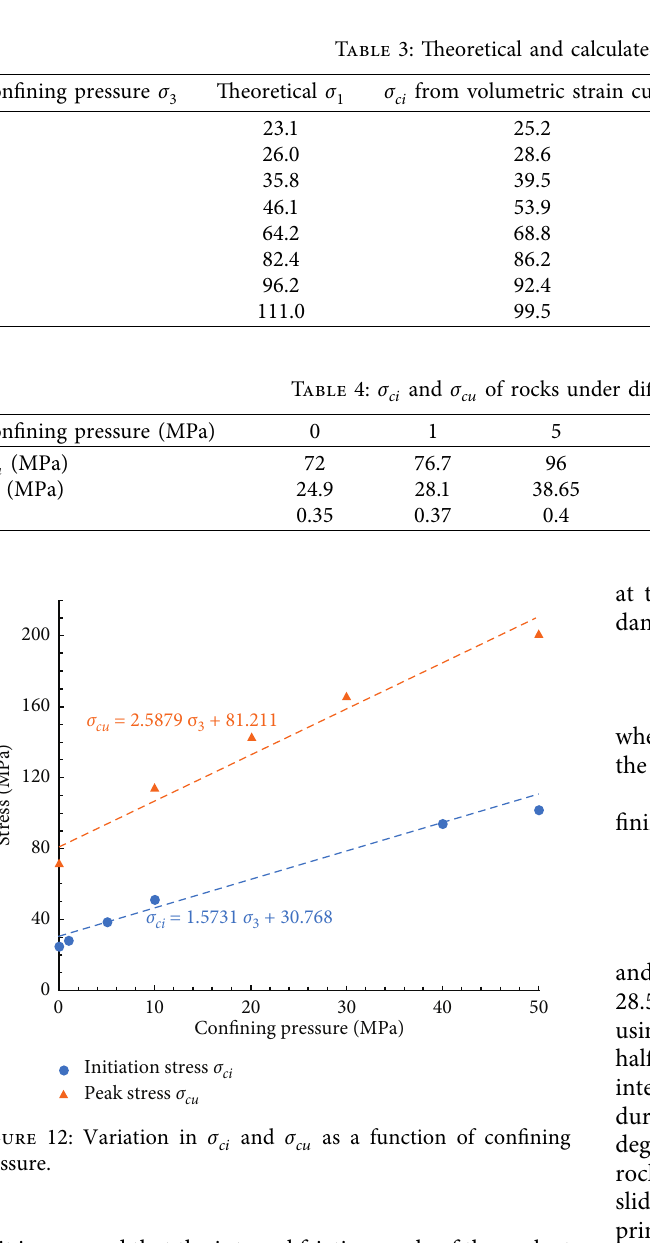
Table 3: Theoretical and calculated values of σ